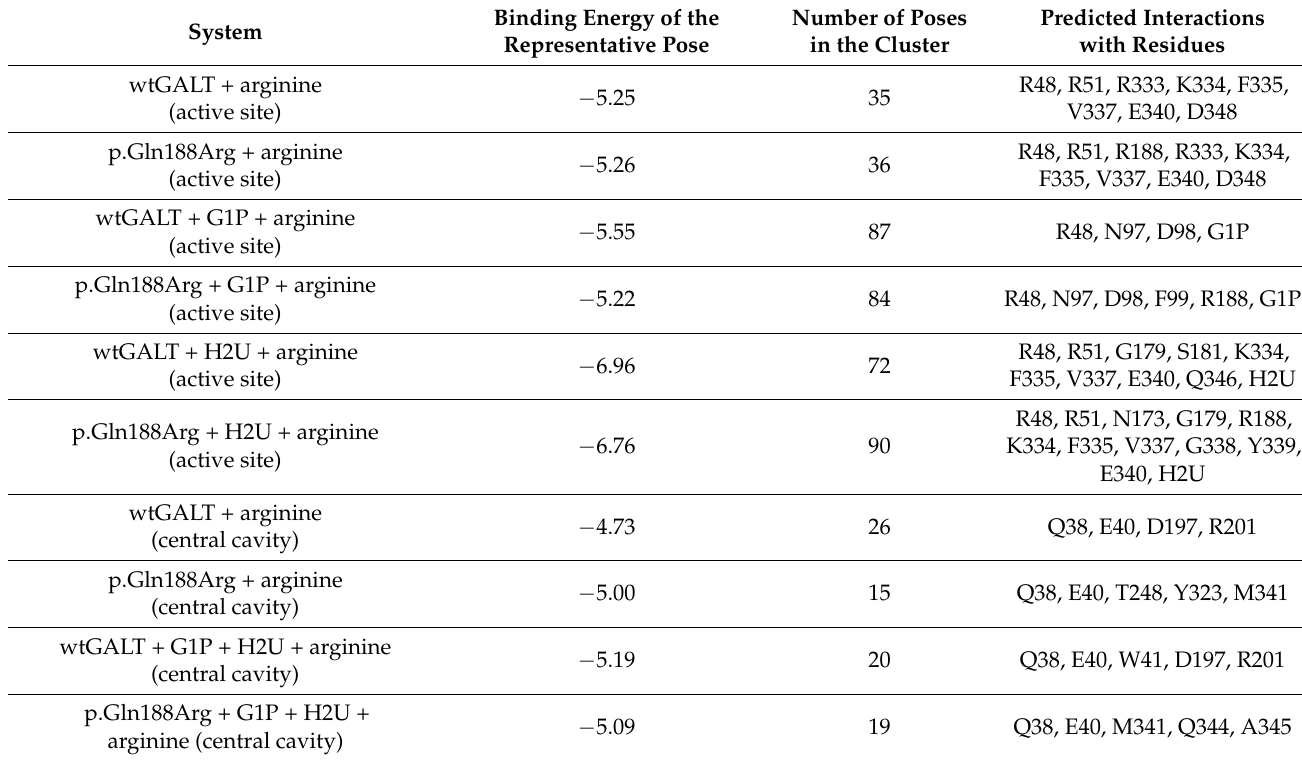
Table 1. Docking results for arginine used as starting point for MD